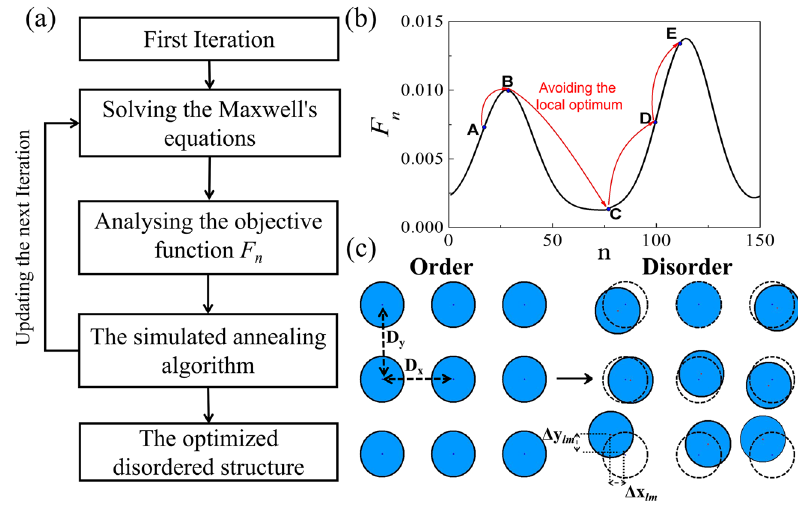
Figure 1: (a) The procedure of combining simulated annealing algorithm (SAA) with the solution of the Maxwell ’ s equations by the finite element method (FEM). (b) The SAA is a random search algorithm